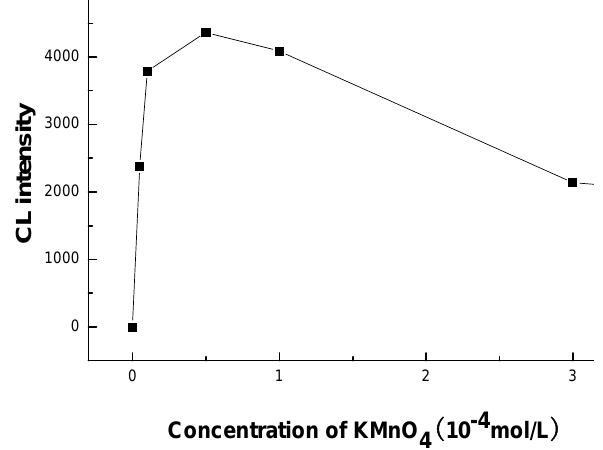
Figure 6. Effect of KMnO